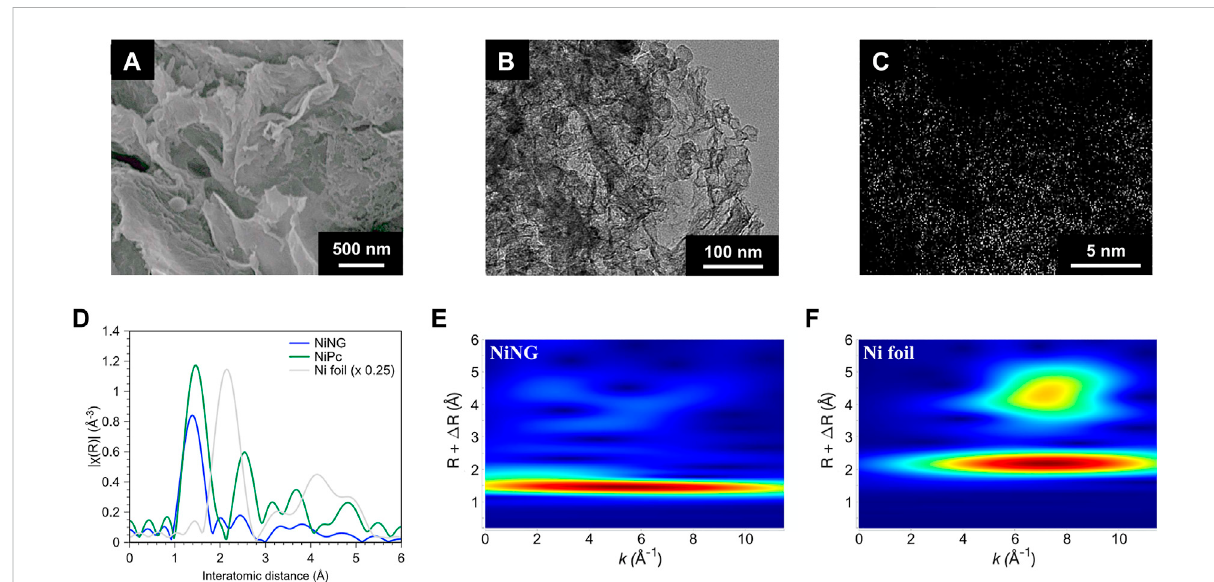
FIGURE 1 Structural identi fi cation of NiNG. (A) SEM and (B) TEM image of NiNG. (C) Cs-corrected HAADF-STEM image of NiNG. (D) Ni K-edge EXAFS spectra of NiNG and the standard of Ni foil and NiPc. Wavelet analysis of the k 2 -weight EXAFS spectra of (E) NiNG and (F) Ni foil as